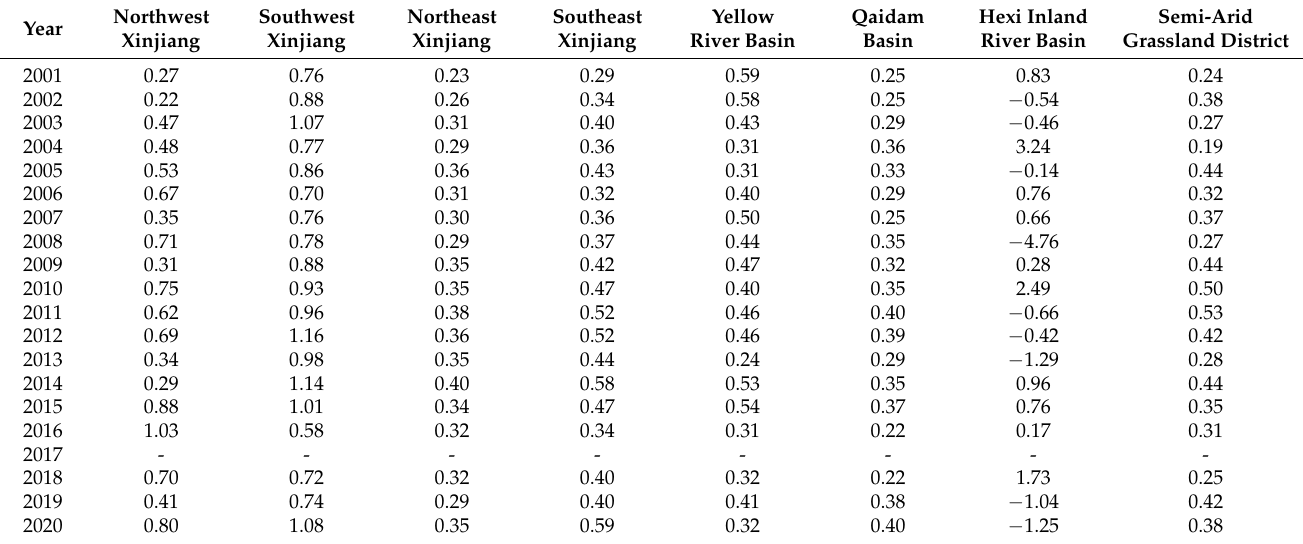
Table 5. IGCI in sub-regions of ‘Three Water Lines’